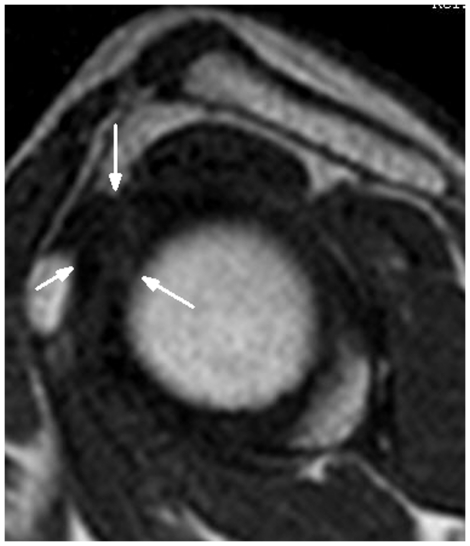
A 54-year-old female normal volunteer.Sagittal oblique, T1-weighted image (TR/TE = 550 ms/15 ms) shows that the distinct fatty tissue surrounding the CHL had disappeared , and the CHL could not be measured (arrows).